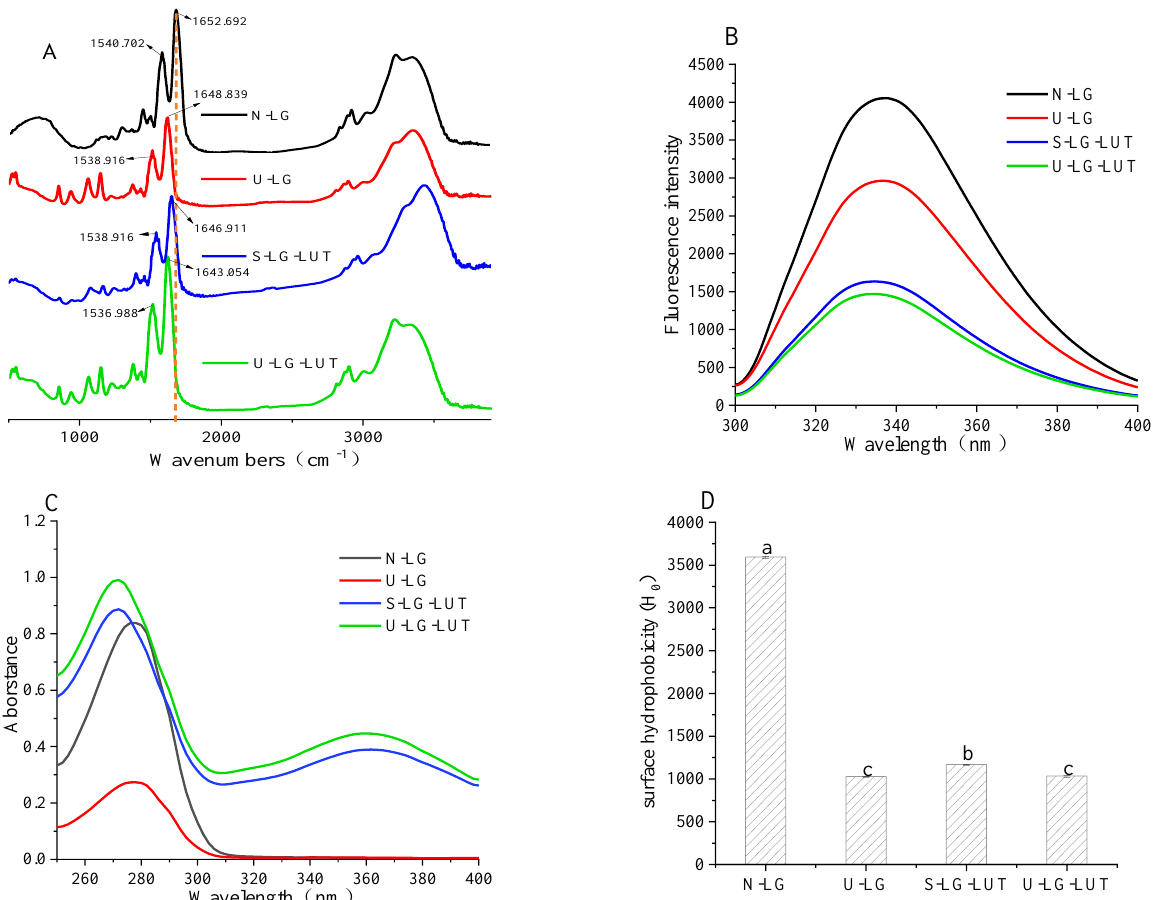
Figure 1. Infrared spectrum ( A ), intrinsic fluorescence intensity ( B ), UV absorption spectrum ( C ) and surface hydrophobicity ( D ) of N-LG, U-LG, S-LG–LUT and U-LG–LUT. Letters (a–c) in the bars mean significantly different ( p < 0.05). Table 1. Secondary structure of N-LG, U-LG, S-LG–LUT and U-LG–LUT. Letters a–d in the table indicate significant differences ( p <